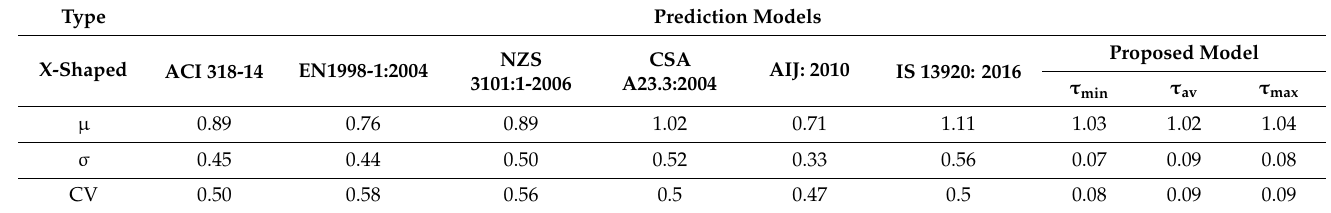
Table 3. Average value, µ , standard deviation, σ , and coefficient of variation (CV) of the ratios of experimental ultimate column shear and available prediction models for X-shaped RC